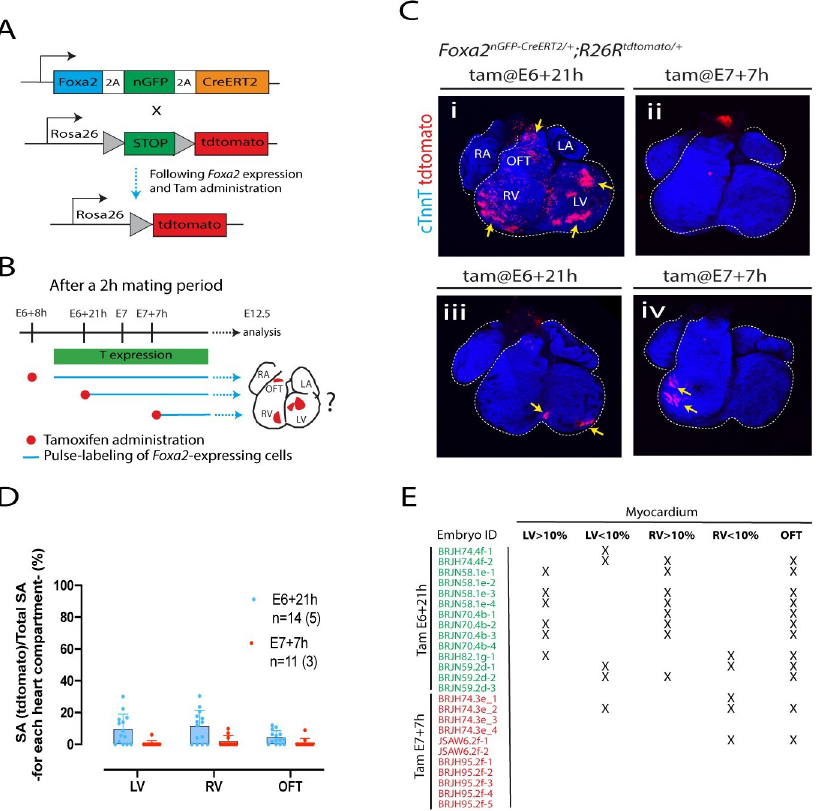
Fig 3. Independent Foxa2+ progenitors contribute to the ventricles and outflow tract. (A) Schematics of the Foxa2 nGPF-CreERT2/+ ; R26R tdTomato/+ allele [16]. (B) Pulse-labelling of the Foxa2 -expressing cells and their descendants, from stage (i) E6+21h, (ii) E7+7h by administration of tamoxifen to Foxa2 nGPF-CreERT2/+ ; R26R tdTomato/+ mice (0.08 mg/ body weight via oral gavage). Cell descendants in the heart analysed at E12.5. (C) Representative hearts resulting from the administration of tamoxifen at different time points in Foxa2 nGPF-CreERT2/+ ; R26R tdTomato/+ immunostained for cTnnT to reveal the cardiomyocytes (blue). Views are ventral. Single epicardial cells are also labelled in (iii). (D, E) Summary of all hearts analysed. The contribution of the Foxa2- expressing cells to the different compartments of the heart is quantified by measuring the proportion of tdTomato-positive myocardium. Numbers in brackets in (E) represent the number of litters assessed. Error bars are SD. Scale bar: 200 μ m. The data underlying (D, E) can be found in S3 Source Data. cTnnT, cardiac troponinin T; LA, left atria; LV, left ventricle; OFT, outflow tract; RA, right atria; RV, right ventricle. streak had extended along its proximal-distal axis, and we found tdTomato-positive cells coex- pressing Foxa2 and T in the aPS (Fig 5B–5G). We also found rare tdTomato-positive cells expressing only T and not Foxa2 (red arrow in Fig 4Cii, yellow arrows in Fig 3F). Quantifica- tion of Foxa2 and T intensities revealed that the tdTomato positive cells located in the aPS coexpress low levels of Foxa2 and T (yellow arrows in Fig 5Ci–5Ciii, Fig 5D–5F and S7A Fig). The tdTomato-positive cells located most distally expressed a higher level of Foxa2 and low or no T (blue arrows in Fig 5Cii and 5Ciii and Fig 5D–5F). These more distal regions correspond to where the axial mesoderm and definitive endoderm are established [27,28]. We conclude that cells expressing Foxa2 early are not contributing to proximal regions of the primitive streak. Instead, these cells maintain Foxa2 expression in the aPS and contribute to the left and right ventricles at the mid-to-late streak stages (Fig 5G and 5H).